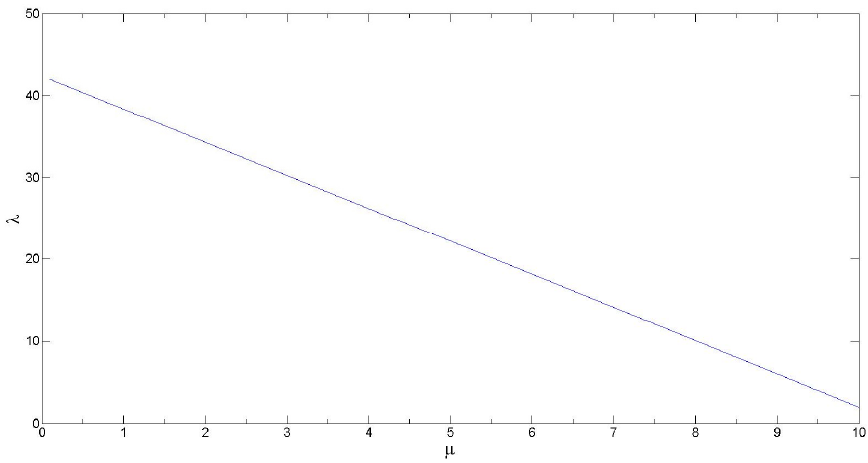
Figure A1. Plot showing the linear relationship between average loss frequency ( λ ) and average loss severity ( µ ). This line can be generated using the following equation: λ = − 20.20 µ + 212.02. Algorithm A5 Procedure for generating synthetic data corresponding to Scenario (V) 1. For i = 1 to n months/years